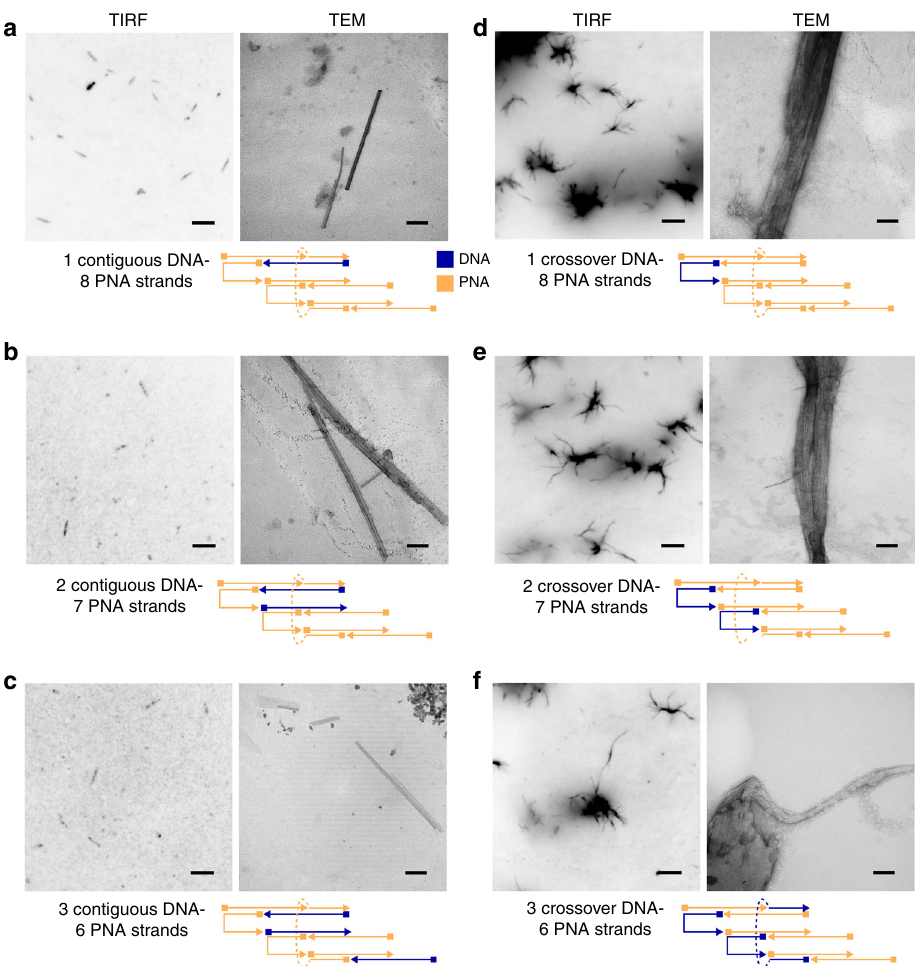
Fig. 3 Self-assembly and characterization of γ PNA – DNA hybrid nano fi bers. TIRF and TEM characterization of γ PNA – DNA hybrid fi laments through selective and sequential replacement of γ PNA oligomers with DNA. Schematic representations (repeated over two independent experiments for each condition shown in a – f ) show the position in the SST motif replaced with DNA (blue arrows) in the context of other γ PNA sequences (orange arrows). Sequential replacement of: a one contiguous γ PNA sequence with DNA, b two contiguous γ PNA sequences with DNA, and c three contiguous γ PNA sequences with DNA resulted in straight fi laments. However, sequential replacement of: d one crossover γ PNA sequence with DNA, e two crossover γ PNA sequences with DNA, and f three crossover γ PNA sequences with DNA resulted in stellate structures with pronounced bundling effects. Scale bars on TIRF images are 5 μ m, and scale bars on TEM images are 100